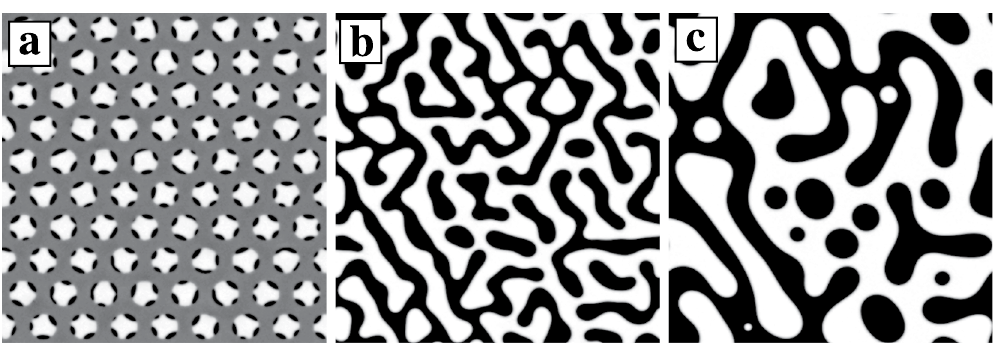
Figure 7. Time evolution of the dendritic pattern with multiple propagated triggers when Δ d = 60, φ = 0.1, and v tri = 0.01. ( a ) By t = 3500, a dendritic pattern has formed at each core. ( b ) At t = 50000, a connected pattern is observed. ( c ) The same can be seen when t = 100000. Connectivity can be seen for a long time despite the fact that φ =